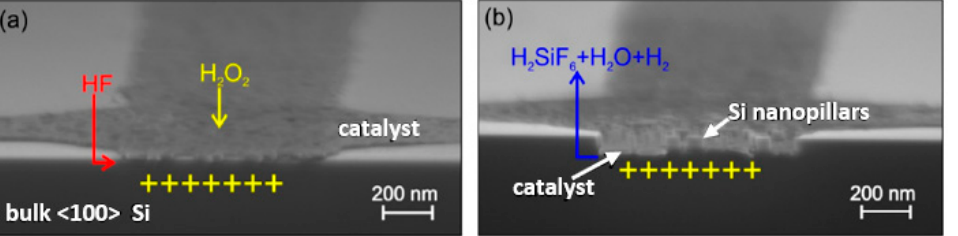
Figure 8. Process of MacEtch with Si as substrate and H 2 O 2 ( a ) Metal catalyst deposits on Si substrate where H 2 O 2 gets decomposed ( b ) Si consumes positive charge and gets oxidized by HF and forms of silicon fluoride-forming Si nano-pillars [102] (published in MDPI open access).